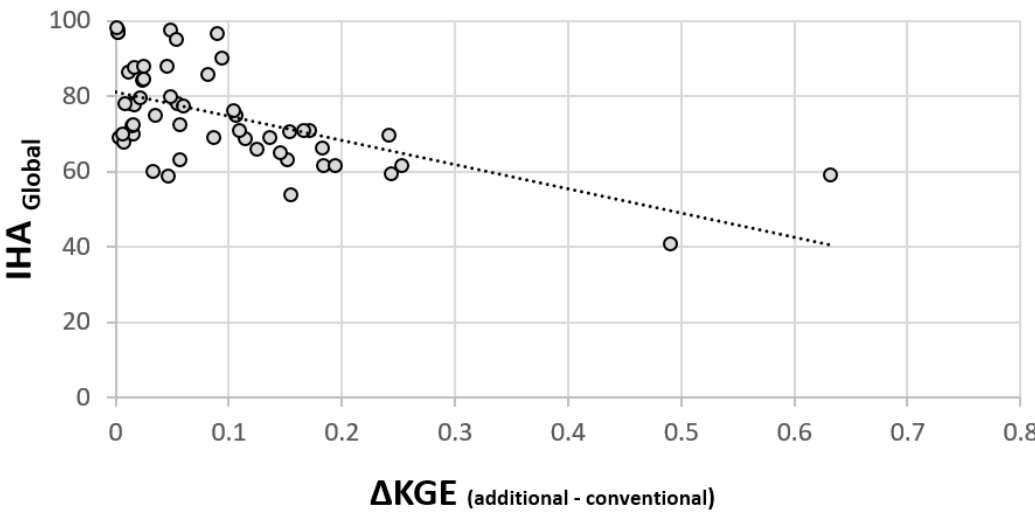
Figure 12. ∆ KGE between conventional (CC) and additional calibration (AC) for 47 gauging stations face to IHA (Hydrological Alteration Index) from 2000 to 2010.